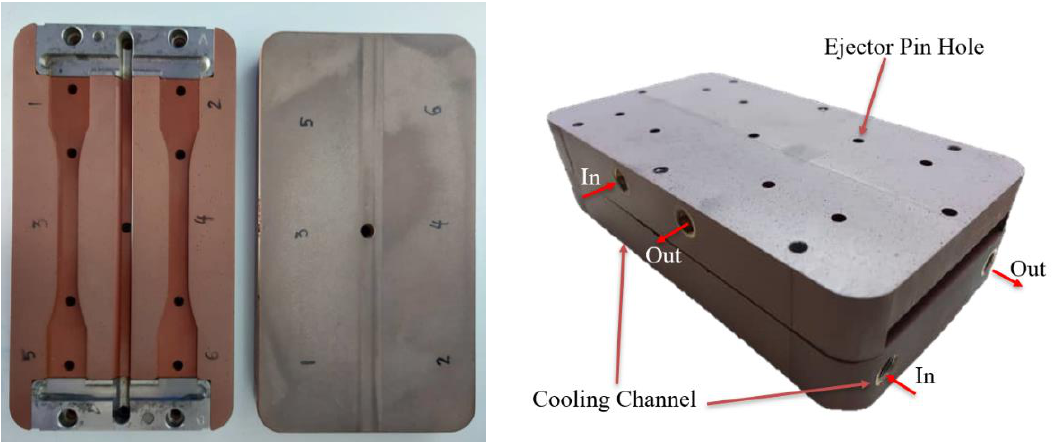
Figure 23. MEC mold insert (60% copper filler).